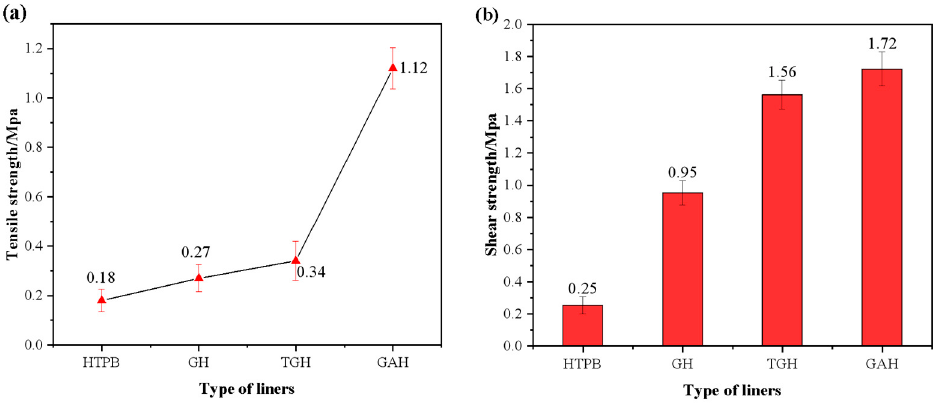
Figure 11. ( a ) Tensile strength and ( b ) Bond strength of the different liners.